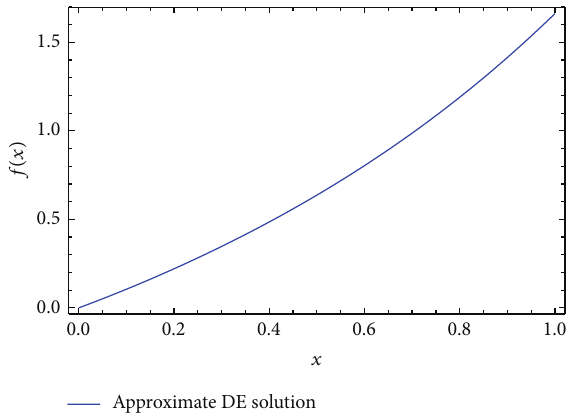
Figure 2: Exact and approximate solution for 𝑦 󸀠󸀠 + 𝑦 󸀠 /𝑥 − (1/𝑥) cos 𝑥 = 0 with 𝑦(0) = 0 and 𝑦 󸀠 (0) = 1 .